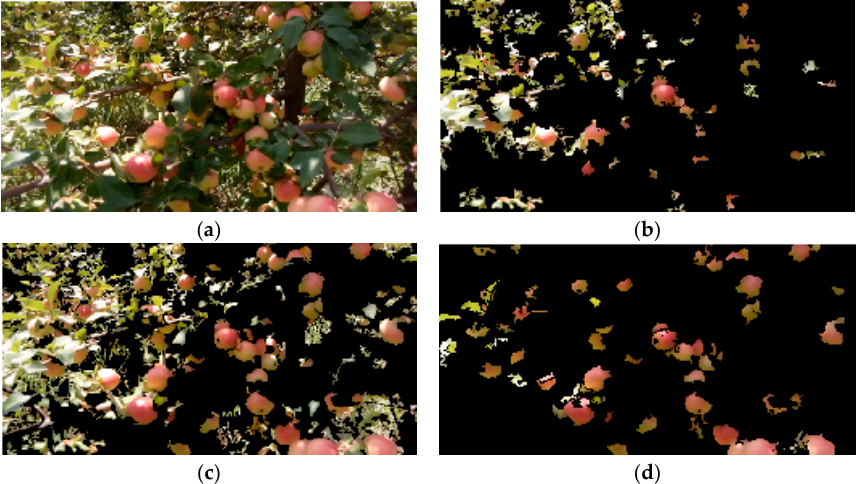
Figure 7. Results of different orders of the color, texture and intensity steps on the segmentation algorithm. ( a ) Original color image of the apples. ( b ) Segmentation in texture, color and intensity order. ( c ) Segmentation in intensity, texture and color order. ( d ) Segmentation in color, texture, and intensity order.